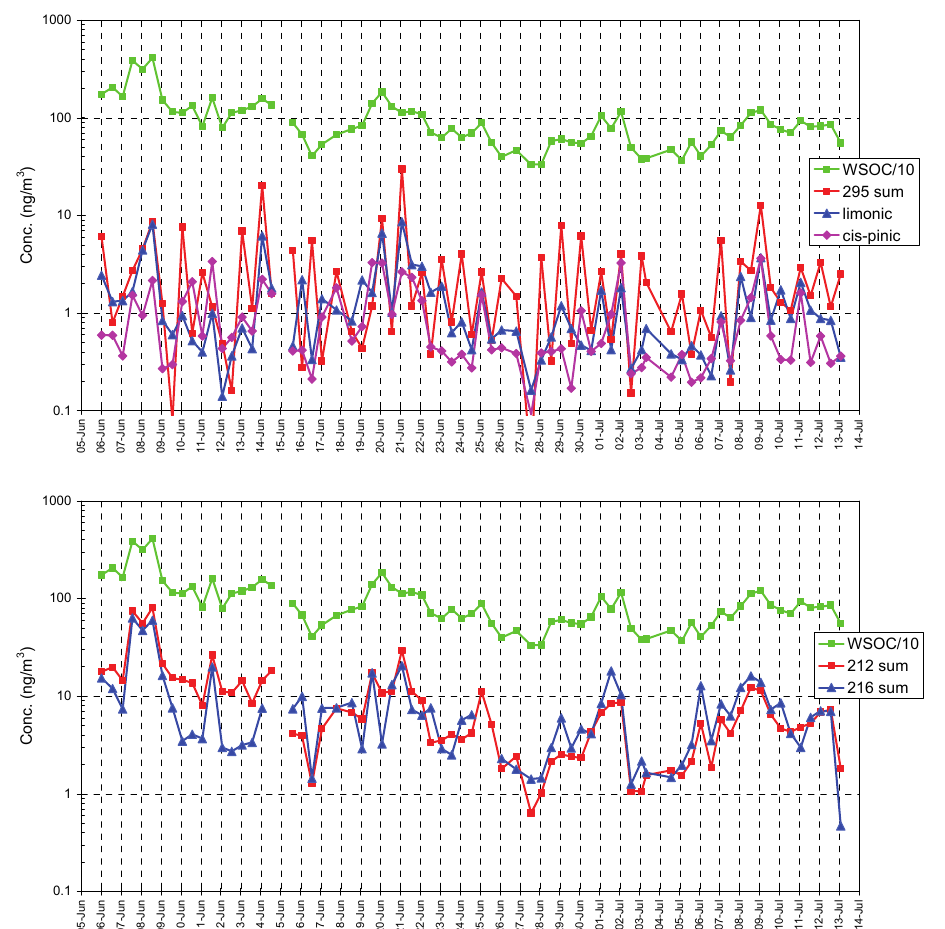
Fig. 5. Time series for (top): the organic species that maximize at night, i.e., the MW 295 α -pinene-related nitrooxy organosulfates, limonic acid, and cis -pinic acid; and (bottom) the 2-methyltetrol (MW 216) and the unknown MW 212 organosulfates, as derived from the PM 2 . 5 front filters of the HVDS, for the 2007 summer campaign in Brasschaat. For comparison, the time series of WSOC, which is a proxy for SOA, is also presented, and for clarity it is repeated in each of the graphs. Note that the α -pinene-related nitrooxy organosulfates (MW 295), limonic acid, and cis -pinic acid mainly peak during night-time, while the MW 216 and 212 organosulfates mainly peak during day-time.